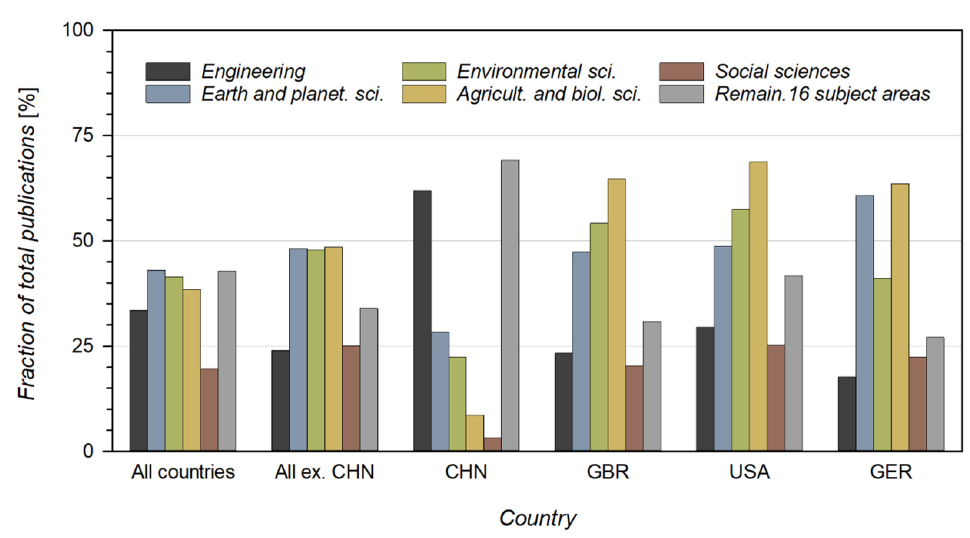
Figure 4. Relative distribution of publications by subject area for each of the main contributing countries, for all countries combined and for all countries excluding China.